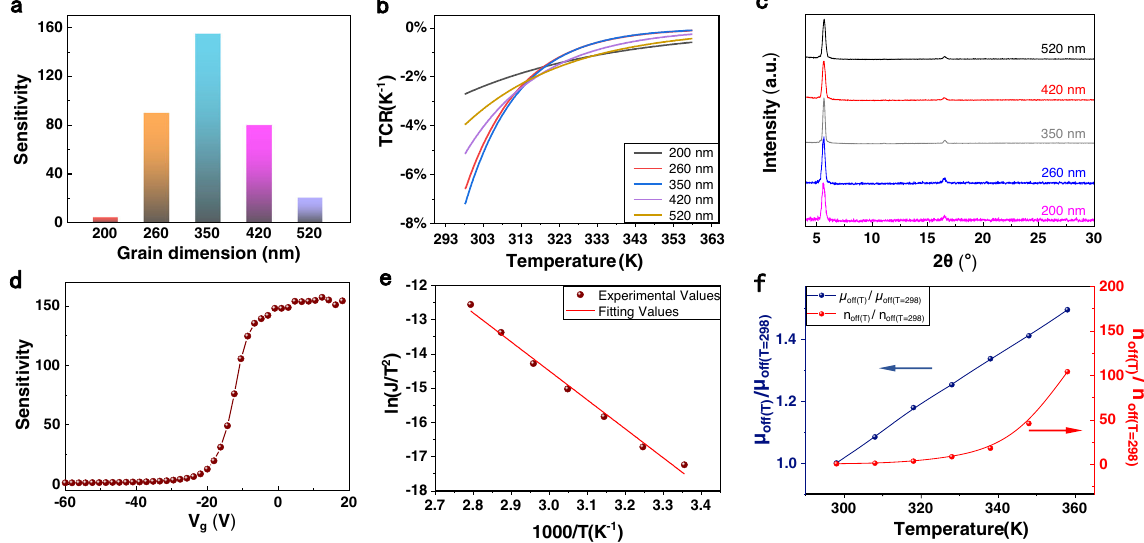
Fig. 3 Effect of the grain size on temperature dependence of OFETs. a Bar chart of the relationship between sensitivity and grain sizes. Sensitivity is de fi ned as [I(V g , T) − I(V g , T 0 )]/I(V g , T 0 )], where V g = 20 V, T 0 = 298 K, T = 358 K. b Temperature coef fi cient of resistance (TCR) of the OFETs with different grain sizes. c X-ray diffraction patterns of DNTT polycrystalline fi lms with different grain sizes. d The correlation between the sensitivity (measured when V ds = − 60 V) and the gate voltage of the OFET. e The fi tting plot of ln J as a function of 1000/ T . f The relative change rate of mobility T 2 and carrier density in the off-state of the OFET. The curves of ( d – f ) were measured by the OFET with grain size of 350 nm. The data of ( a , b and e – f ) were measured in the off-state ( V g is 20 V) when V ds is − 60